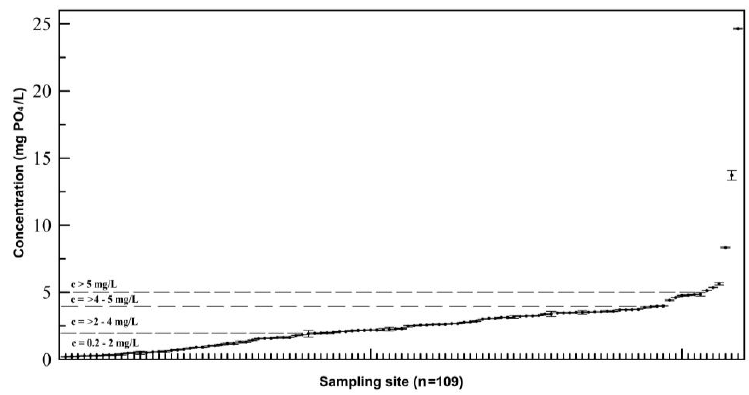
Figure 2. Concentrations of phosphates in mg PO 4 /L (from min. to max. concentration).